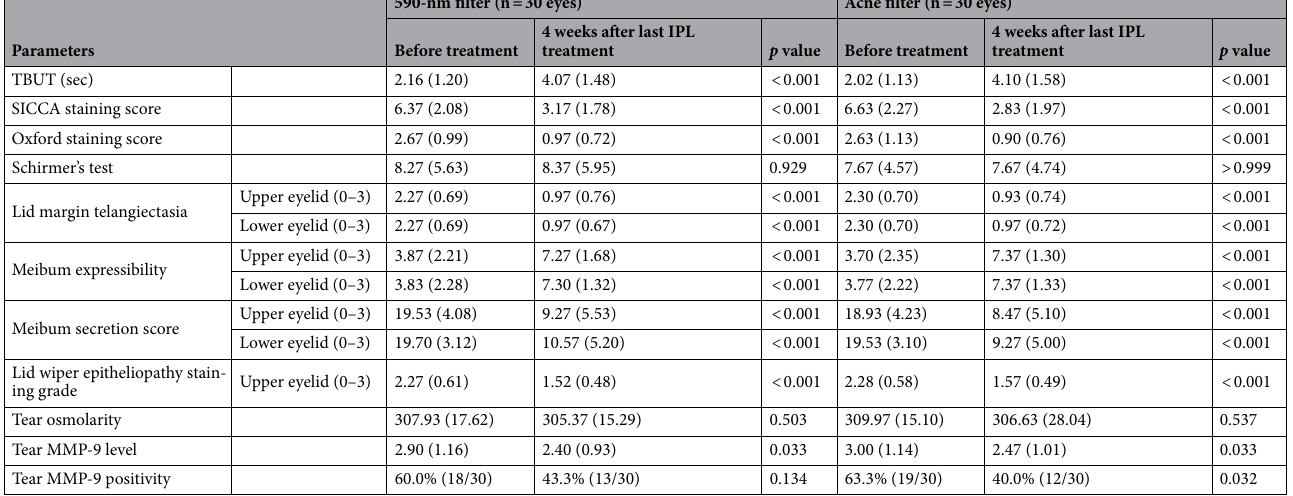
Table 2. Comparison of clinical signs and symptoms before treatment and 4 weeks after the last treatment of intense pulsed light (IPL) with each filter (590-nm or acne filter) in patients with moderate to severe meibomian gland dysfunction. Results are presented as mean (standard deviation). IPL, intense pulsed light; TBUT, tear film break-up time; SICCA, Sjögren’s International Clinical Collaborative Alliance; MMP-9, matrix metalloproteinase-9.